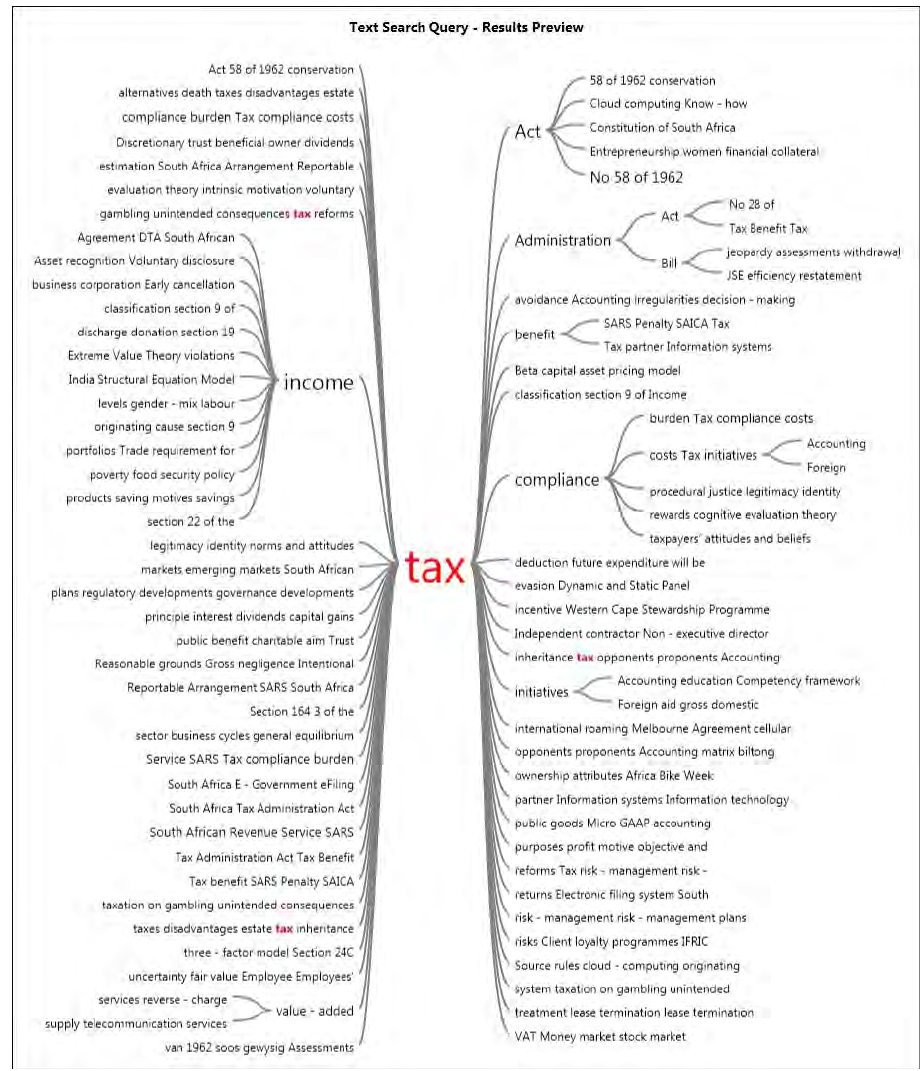
FIGURE 8: Word Tree Diagram: ‘Tax’ Source: